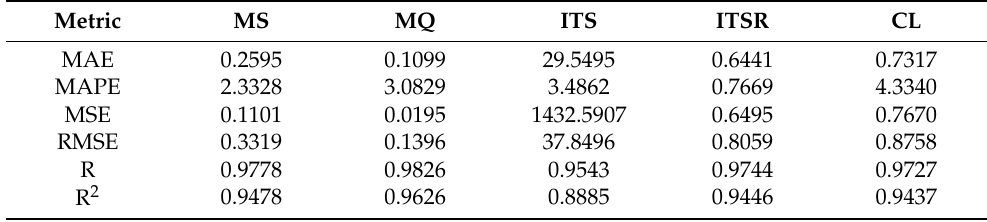
Table 7. CatBoost model performance